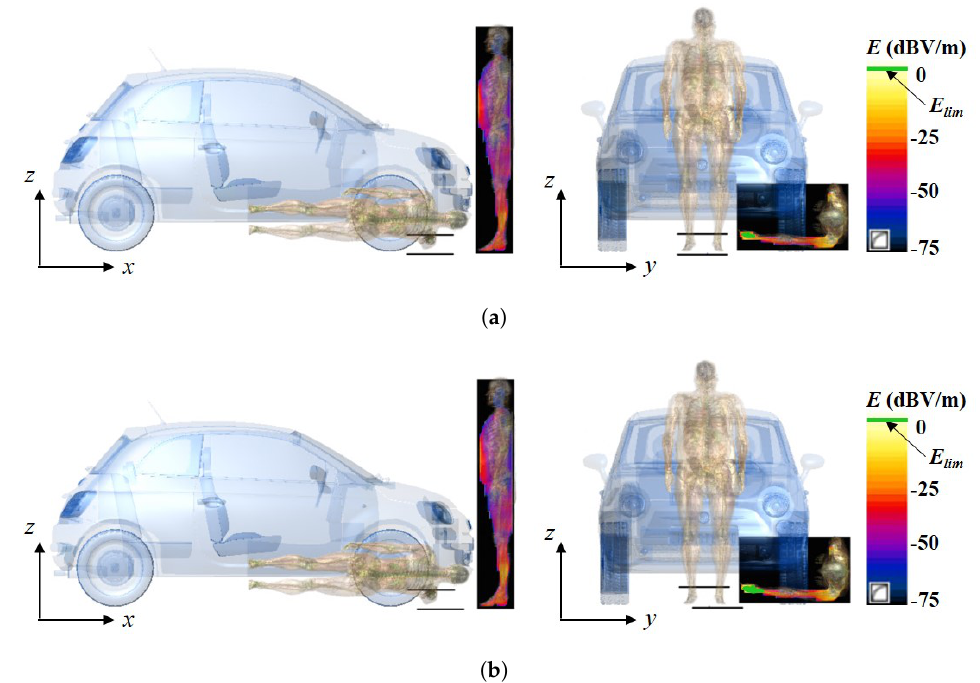
Figure 6. E -field distributions for exposure scenario #2 in the aligned ( a ) and misaligned ( b ) coil positions. E lim is the BR = 11.48 V/m (the green area is the portion where the BR is exceeded).